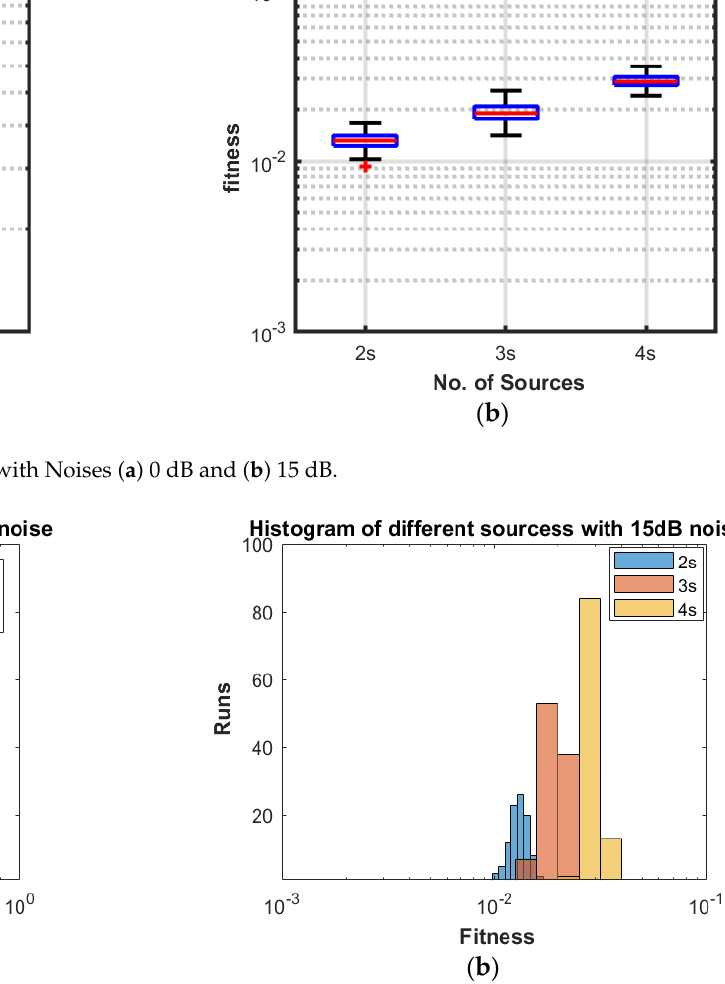
Figure 7. Histogram with Noises ( a ) 0 dB and ( b ) 15 dB.